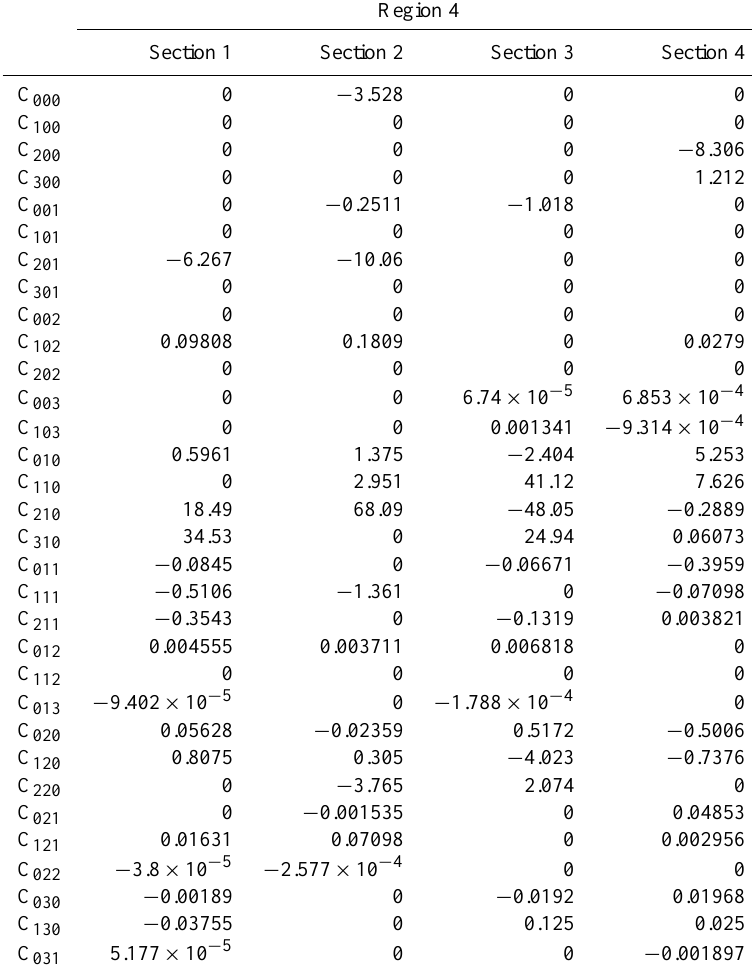
Table 6. Similar to Table 3, but for region